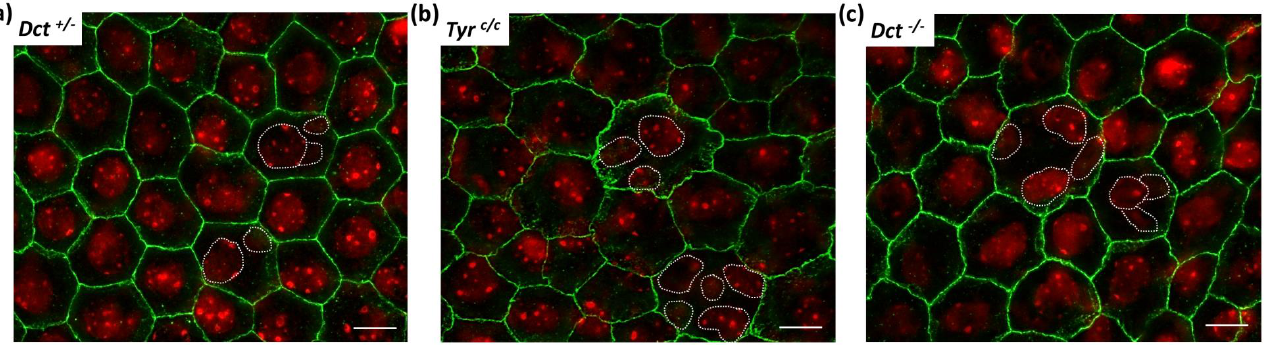
Figure 5. P-cadherin labeling of newborn (P0.5) RPE. RPE flat mounts were immunostained with anti-P-cadherin antibodies that label the adherens junctions in green, scale bar: 10 µ m. Nuclei were stained with DAPI and are shown in red. Each picture is a stack of 4 to 6 Z-planes (0.2 µ m) for flatness compensation and volume rendering; ( a ) Dct +/ − used as wild-type littermate control; ( b ) Tyr c/c used as age-matched non-littermate albino control; ( c ) Dct − / − . This labeling reveals abnormal adherens junction in Dct − / − mice similar to Tyr c/c . Note that the bigger cells in Tyr c/c and Dct − / − are mostly multinucleated (nuclei oulined with white dotted